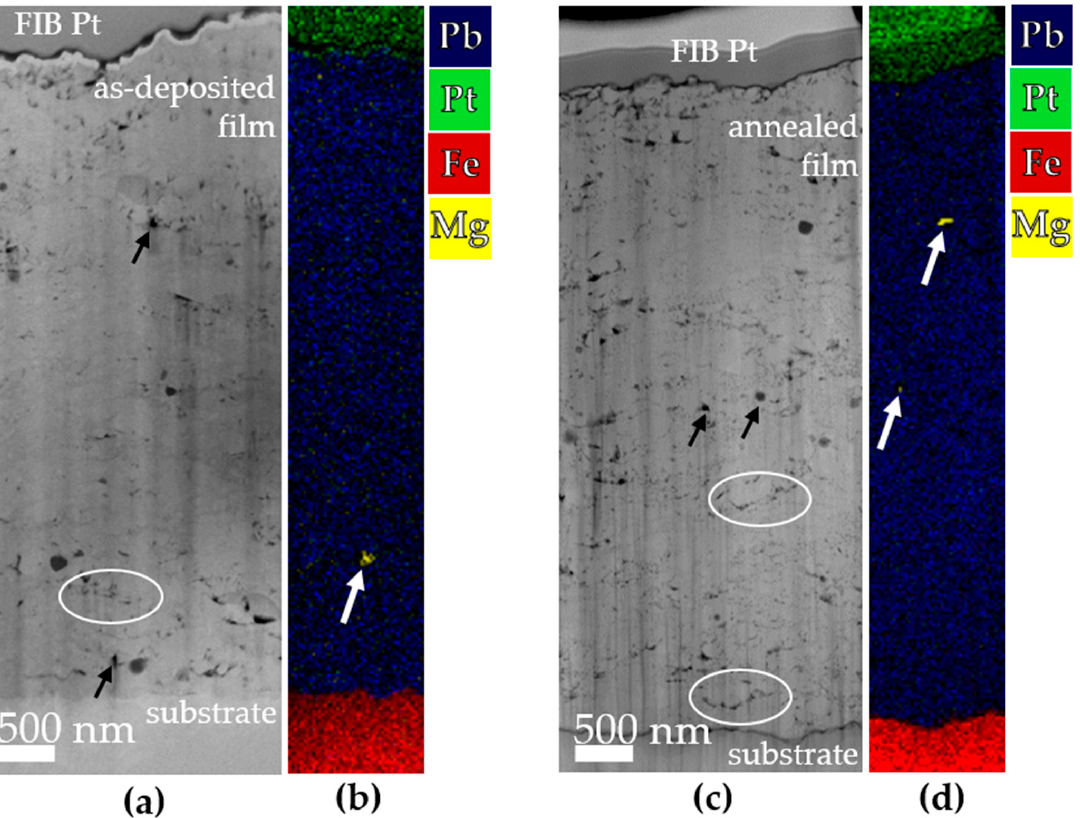
Figure 1. STEM dark-field and EDS analyses, respectively, of the ( a , b ) the as-deposited film and ( c , d ) the annealed PMN − 10PT thick film. The black arrows on the STEM images ( a , c ) indicate larger pores in the films, while the circles mark the chain-like defects composed of nanopores. White arrows in the EDS mapping ( b , d ) mark Mg-rich inclusions in the films. Spectral lines Pb L, Pt M, Fe K, and Mg K were used for the EDS mapping.